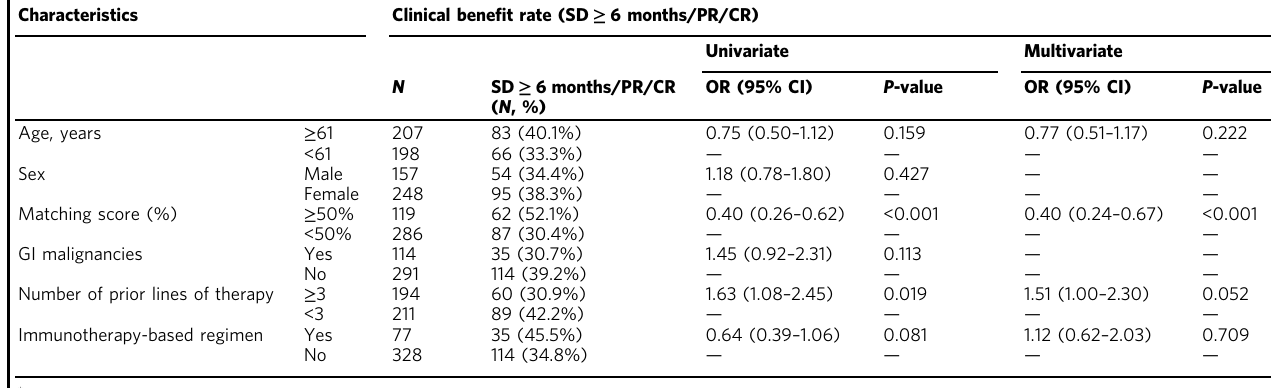
Table 3 Association between patient and treatment characteristics and clinical bene fi t rate (SD ≥ 6 months/PR/CR) ( N = 405*).